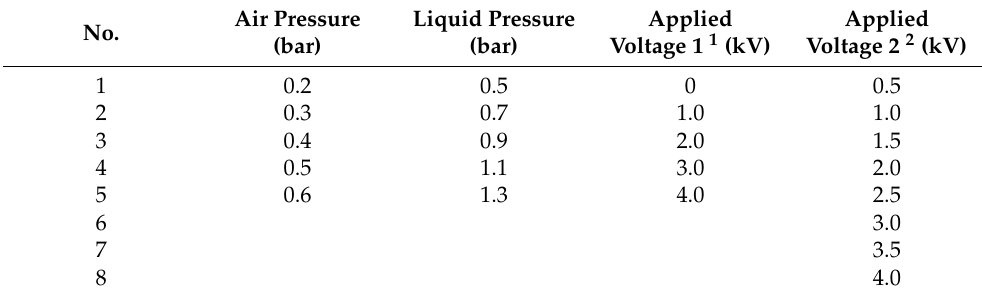
Table 1. The levels of the three parameters.